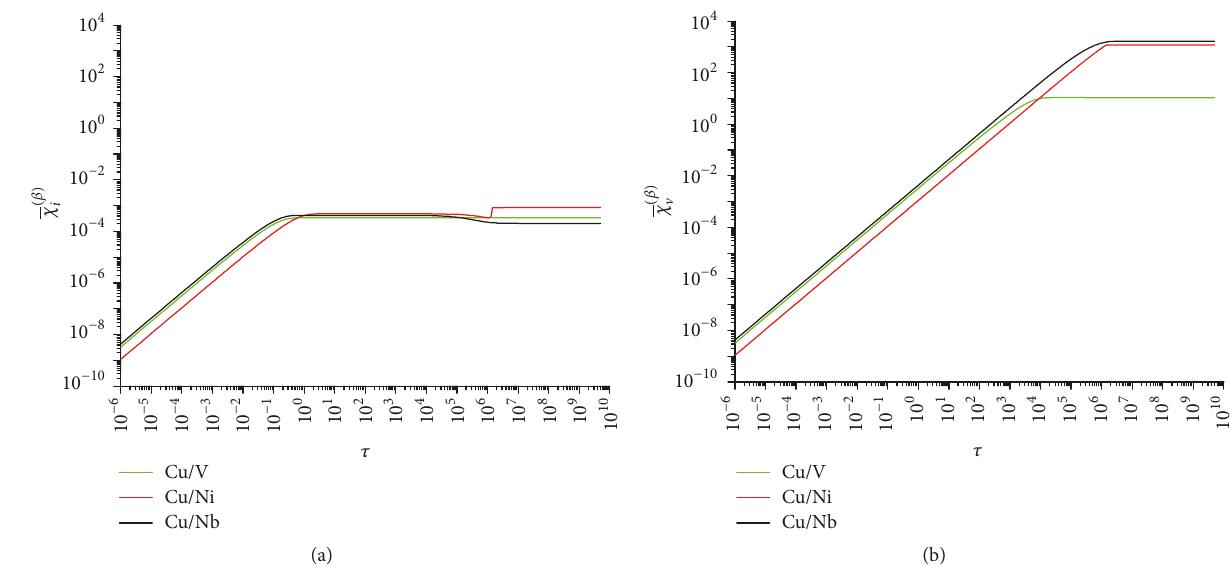
Figure 3: Temporal profiles of average (a) SIA and (b) vacancy concentration in layer 𝛽